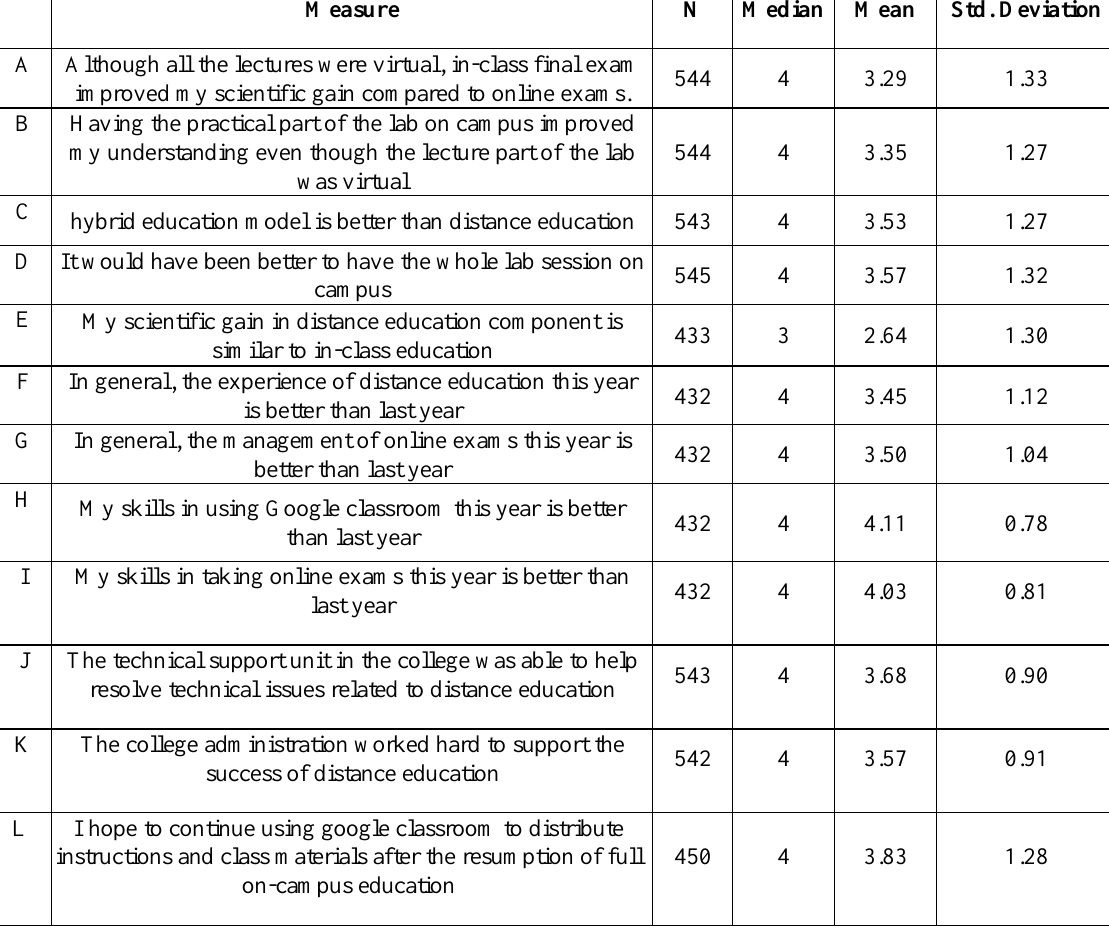
Table 1. The descriptive characteristic of the student perceptions about the college teaching modes.